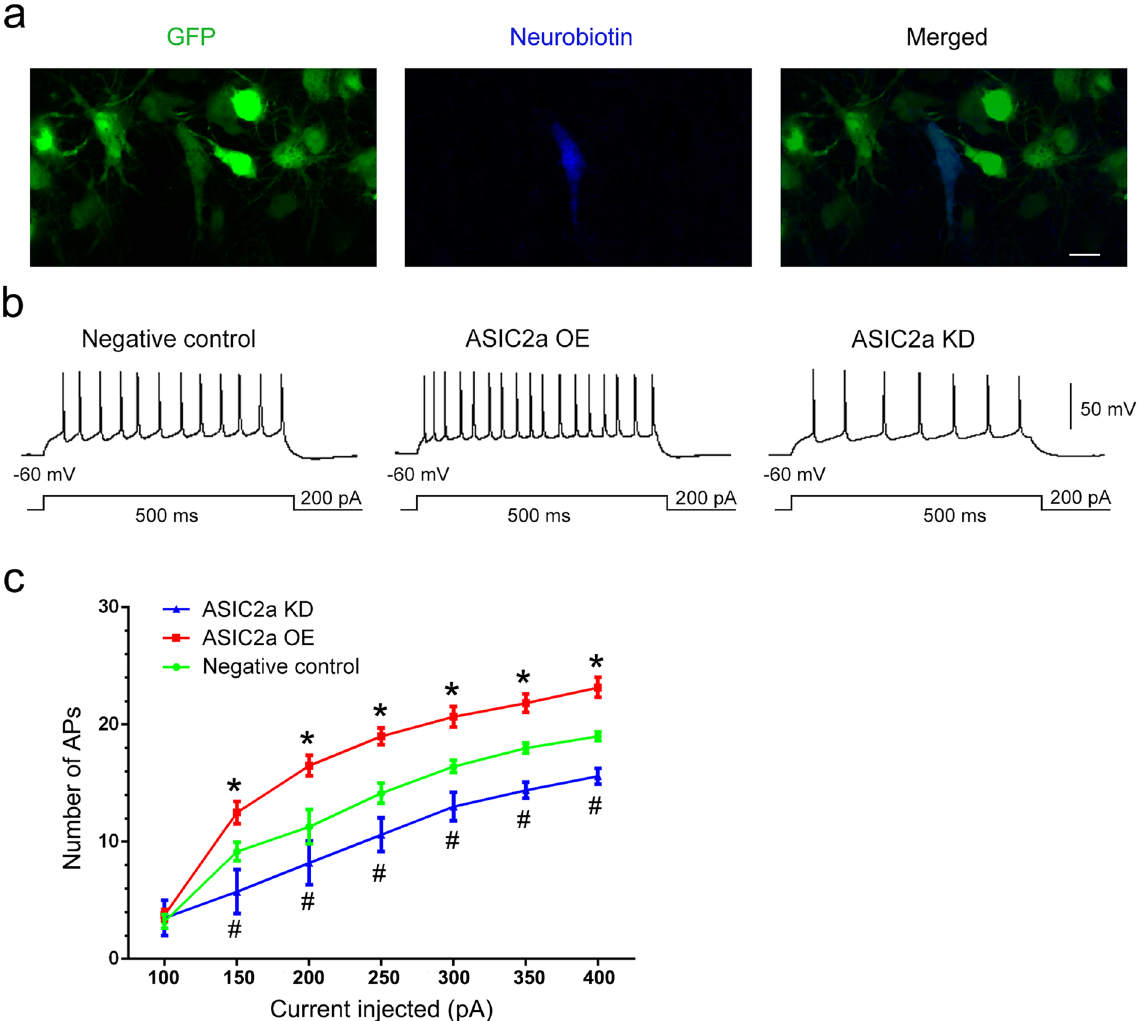
Figure 6. Changes in ASIC2a expression affected the intrinsic excitability of CA1 pyramidal neurons. ( a ) Confocal images of CA1 pyramidal neurons expressing GFP (green) and labelled with neurobiotin (blue). Scale bar = 10 μ m. ( b ) Representative traces of action potential firing in response to 200 pA current injections in CA1 pyramidal neurons of the negative control, ASIC2a overexpression, and ASIC2a knockdown groups, respectively. ( c ) Number of action potentials in CA1 pyramidal neurons from the various groups at different current injection steps. Data are presented as means ± standard errors and were analysed using 1- or 2-way ANOVA and Dunnett's multiple comparisons test. * P < 0.05, ASIC2a OE group compared with negative control group; # P < 0.05, ASIC2a KD group compared with negative control group. Abbreviations, ASIC2a: acid-sensing ion channel 2a; GFP: green fluorescent protein; OE: overexpression; KD: